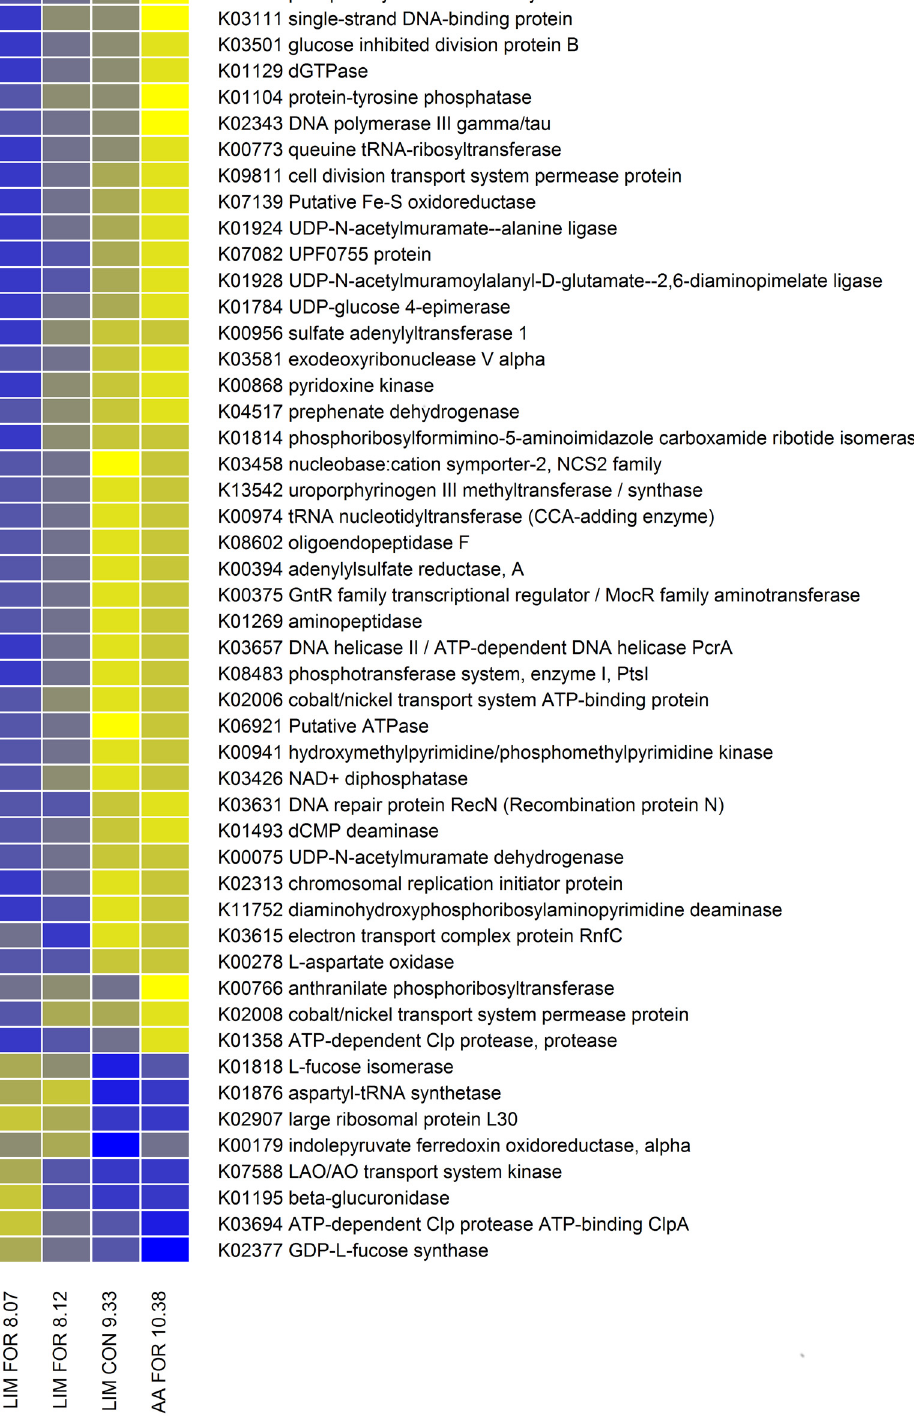
Fig 5. Heatmap of the relative abundance of microbial genes associated with feed conversion efficiency as identified in the partial least squares analysis. The relative abundance of microbial genes (blue = low to yellow = high) changed depending on feed conversion ratio (kg feed intake/kg growth) for the animals selected for low and high methane emissions within breed type and diet. The labels on the horizontal axis represent the breed type (AA = Aberdeen Angus sired, LIM = Limousin sired), diet (CON = concentrate based diet, FOR = forage based diet) and the feed conversion ratio (kg daily feed intake / kg daily